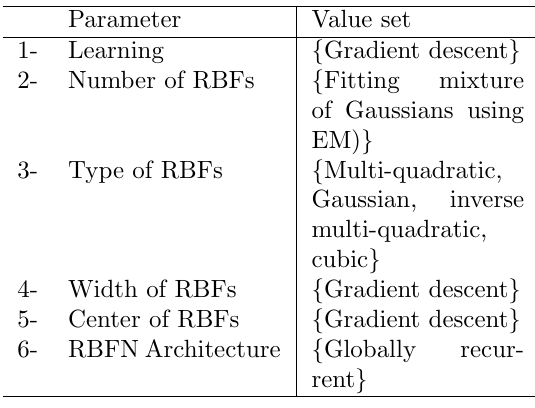
Table 2. Diversity